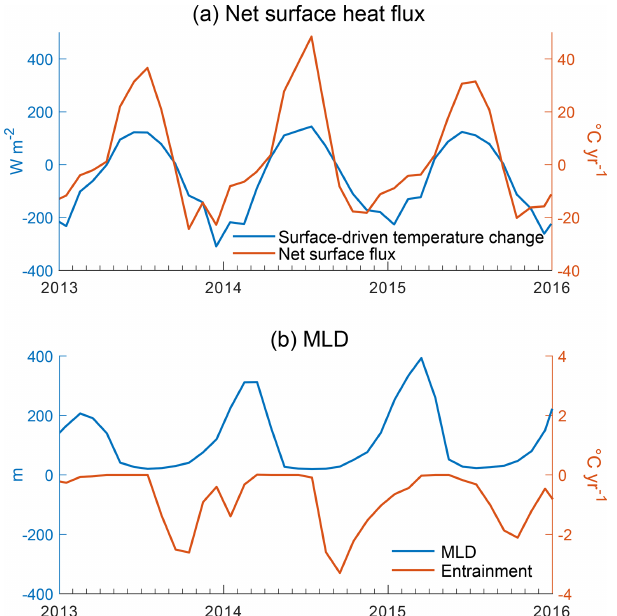
Figure A2. Time series of the individual components that comprise the dominant ECCOv4-r4 temperature budget terms and the associated change in mixed-layer temperature, averaged over the cold blob region. (a) The heat flux into the surface output by the model, defined as Q net in Eq. (1) (Wm − 2 ; blue), and the associated change in mixed-layer temperature, i.e. the surface flux term of the mixed-layer budget ( ◦ Cyr − 1 ; red). (b) MLD (m; blue) and the associated entrainment term of the mixed-layer budget ( ◦ Cyr − 1 ;